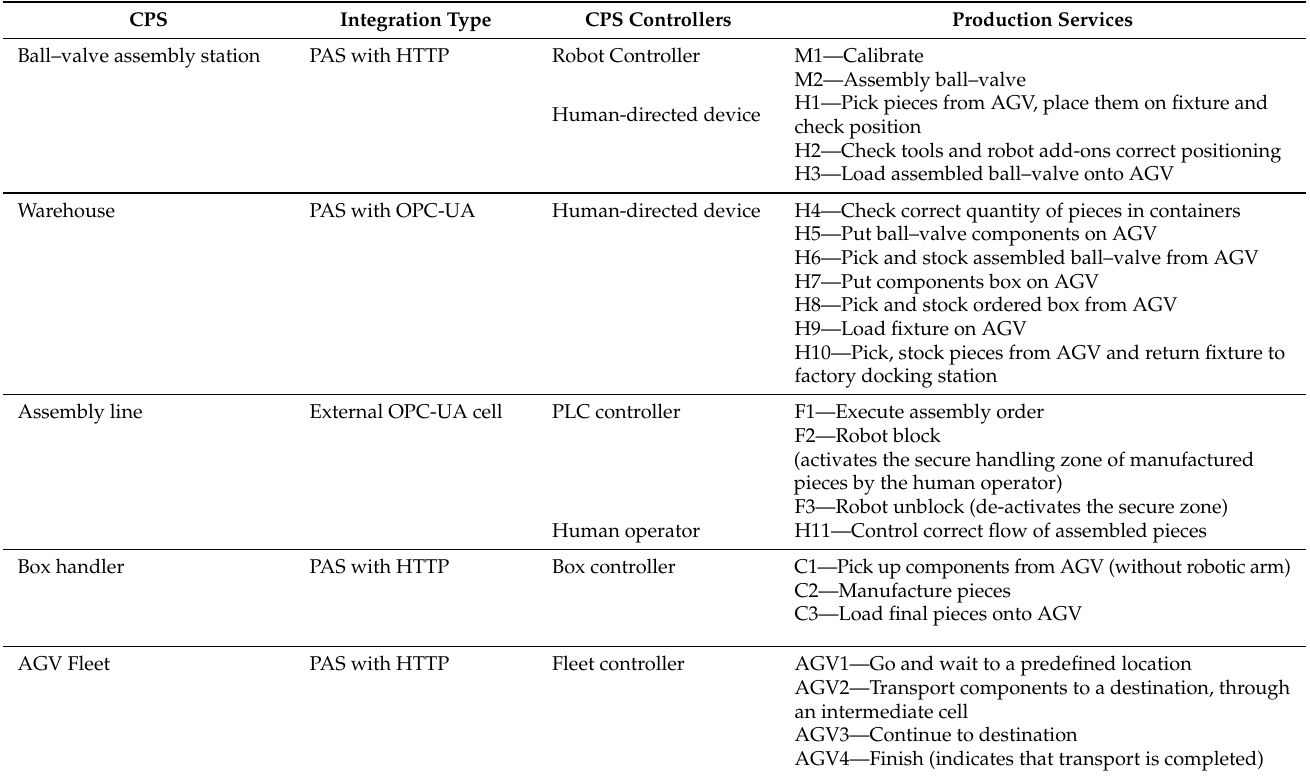
Table 5. List of published services for each